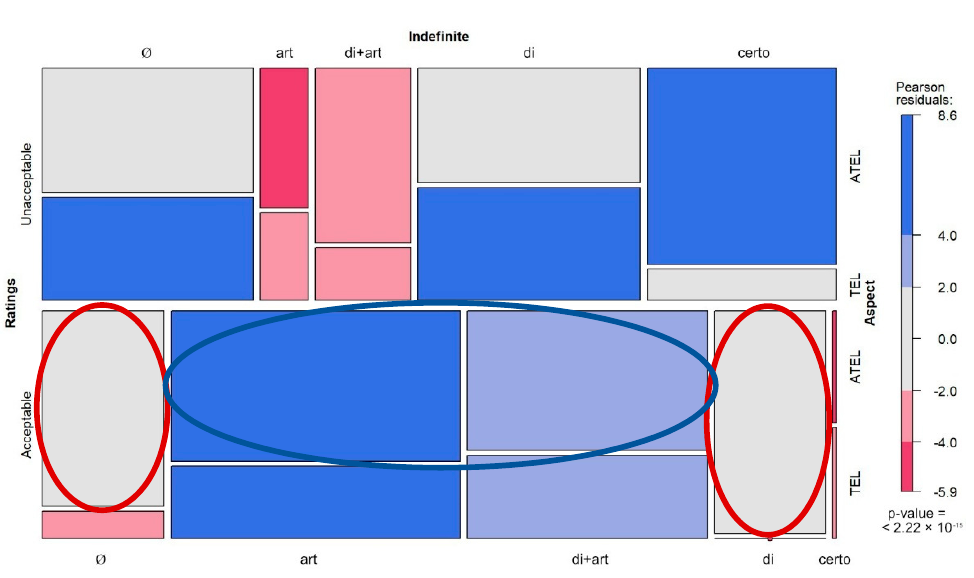
Figure 9. (Un)acceptability rate of each indefinite determiner with telic and atelic predicates. The red circles highlight the similar behavior of ZERO and bare di , while the blue circle indicates a similar behavior of ART and di +art.